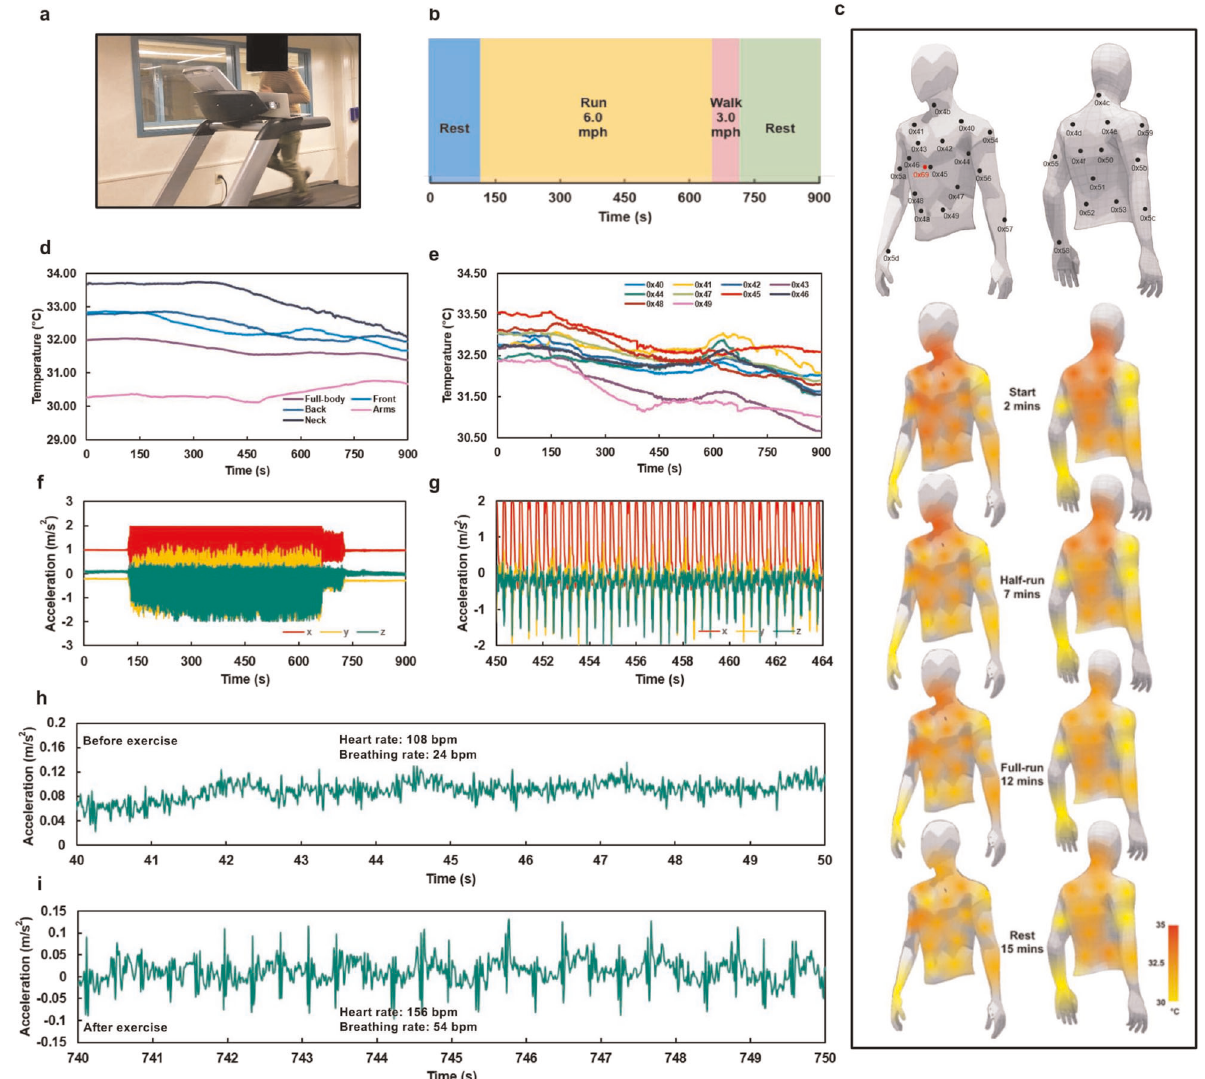
Fig. 5 Physical exercise, spatiotemporal physiological mapping, and movement analysis. a Photograph of a subject performing the physical exercise task wearing a E-TeCS. b Timeline of four separate sections of the physical exercise task. c Sensor mapping and body heat- map of the subject throughout the exercise. d Full-body and each section of the body skin temperature, and ( e ) anterior skin temperature sensor data during the exercise. All 3-axis accelerometer data ( f ) throughout the entire task. ( g ) in the middle of a graded load test at 6 mph. Raw z-axis sensor reading ( h ) before and ( i ) after the